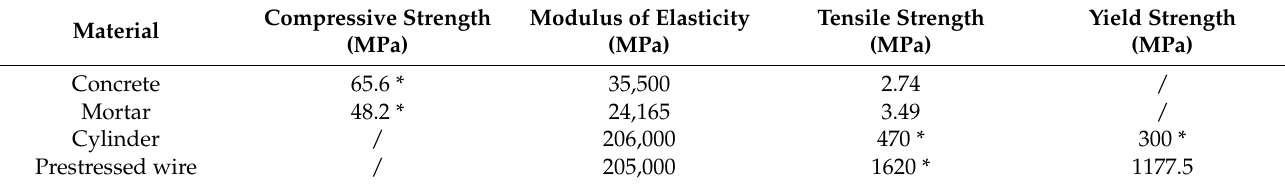
Table 2. Material properties of tested